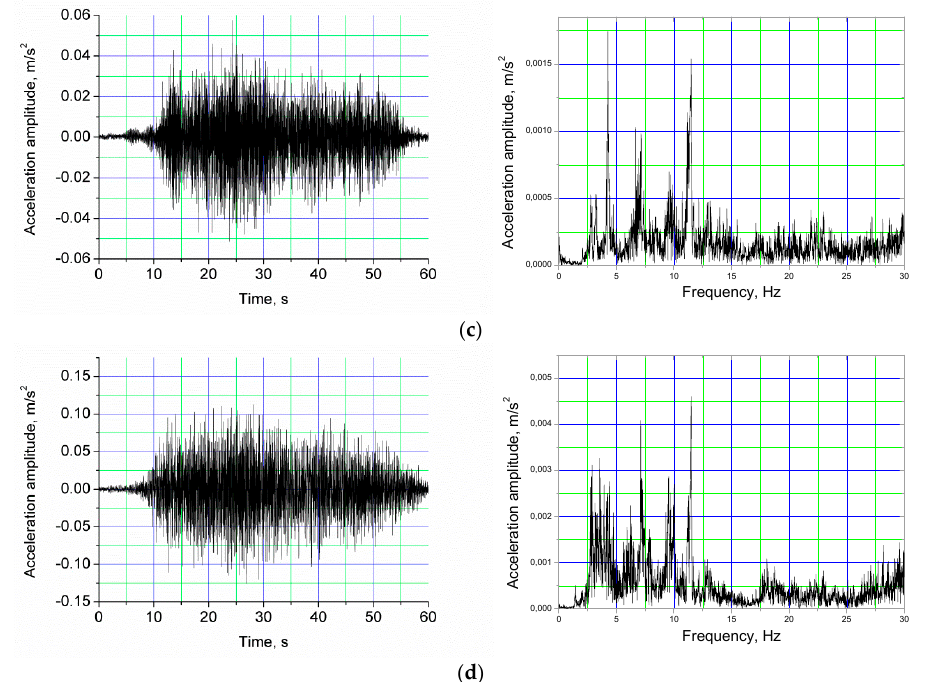
Figure 4. Vertical ( a , c ) and longitudinal ( b , d ) vibrations and their spectral density of the support (filtered vibrations above 30 Hz): ( a , b ) during the locomotive movement; ( c , d ) during the freight train movement.